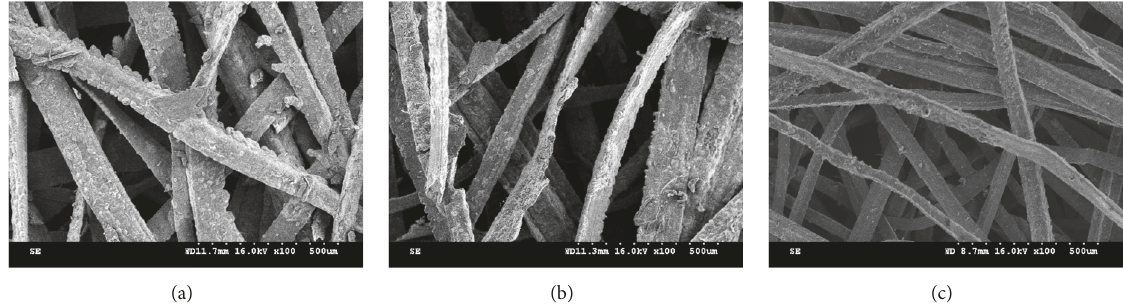
Figure 8: The SEM photographs of the PFMM’s cross sections: (a) sample #1; (b) sample #2; (c) sample